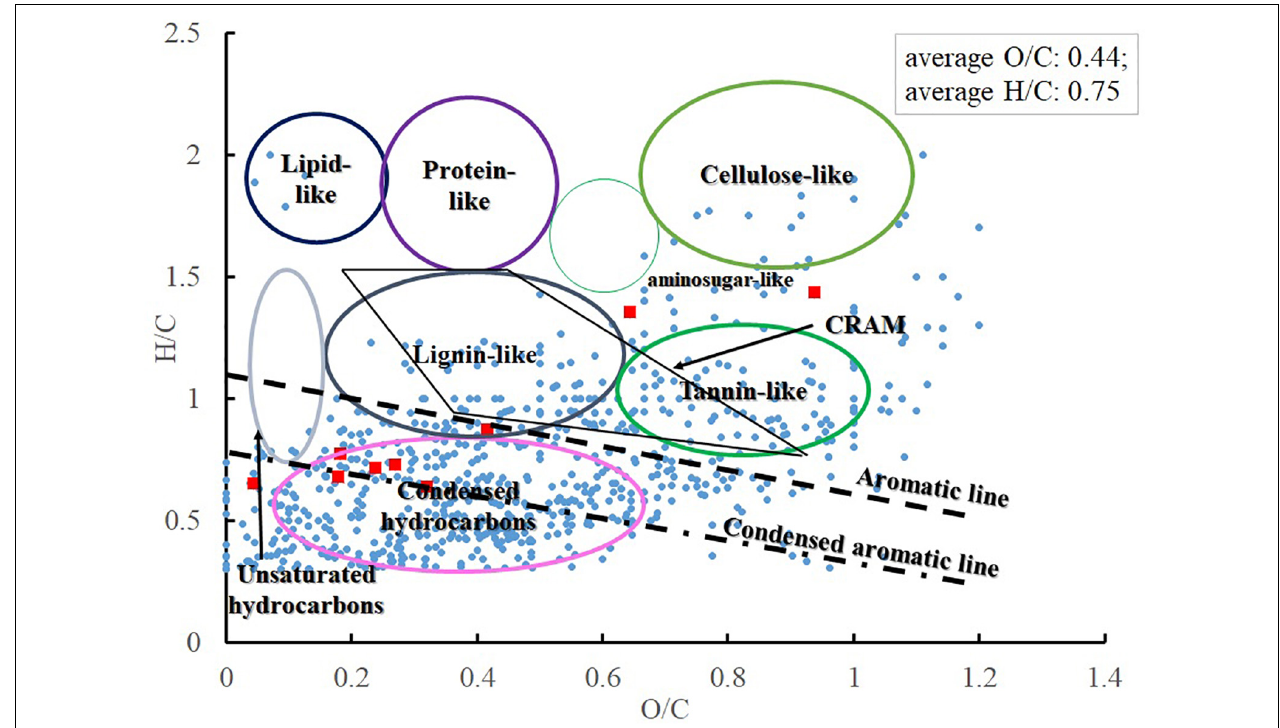
FIGURE 6 | Compound classification of Fe-carrying compounds from three extractants (blue circle, Fe-containing formulas; red square, Fe, hydroxamate-like containing